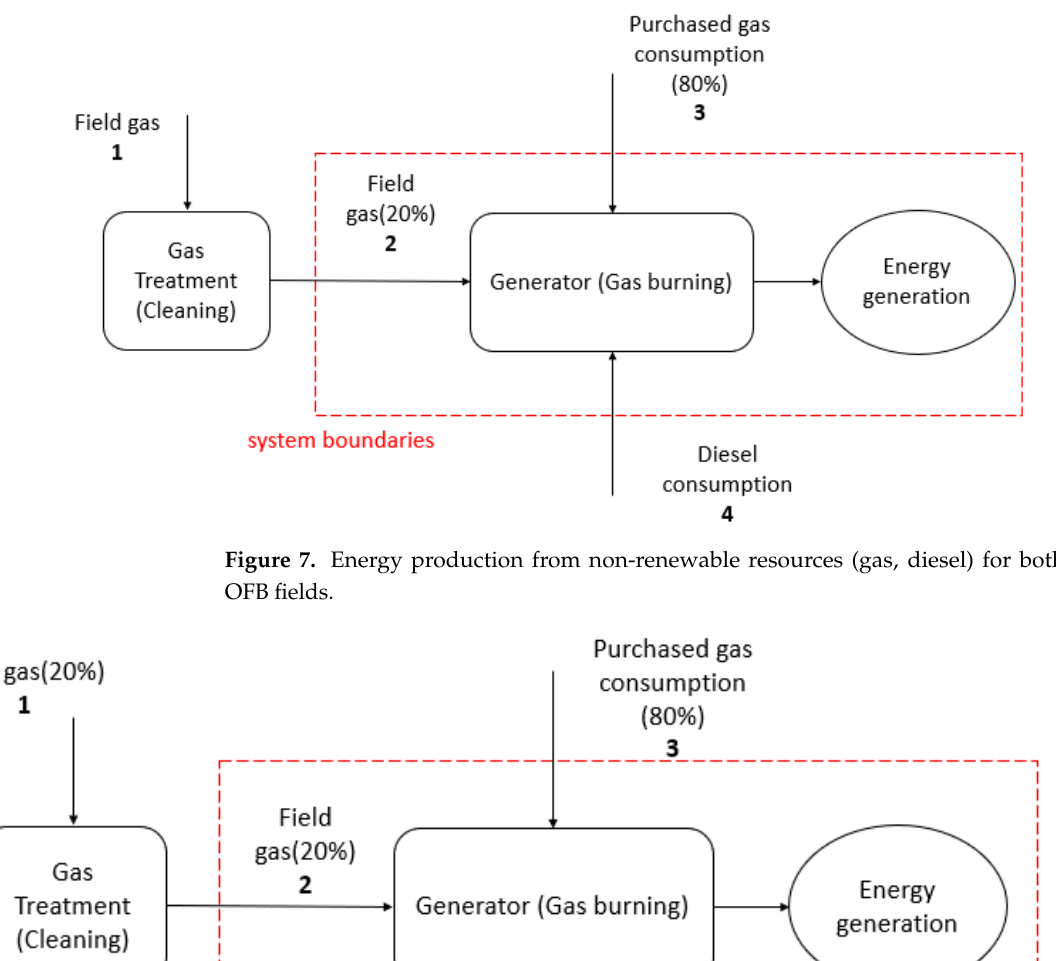
Table 4. Input sources for energy production from non-renewable resources.